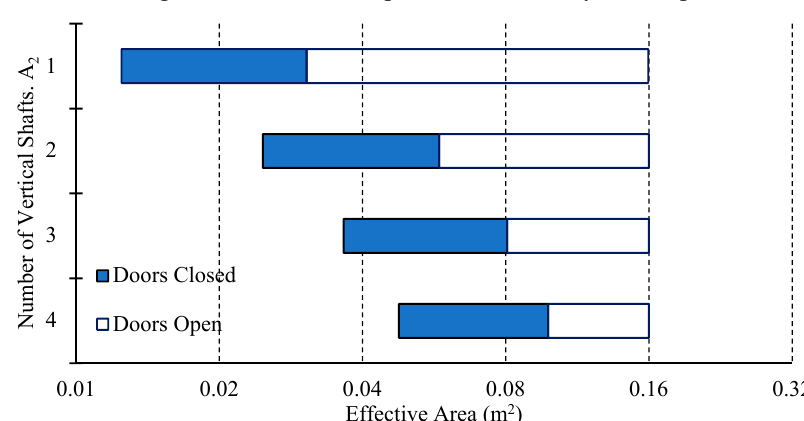
Figure 8. The effective area per floor (A 1 and A 2 ) is influenced by the number of vertical shafts. Figure 8. The e ff ective area per floor (A 1 and A 2 ) is influenced by the number of vertical